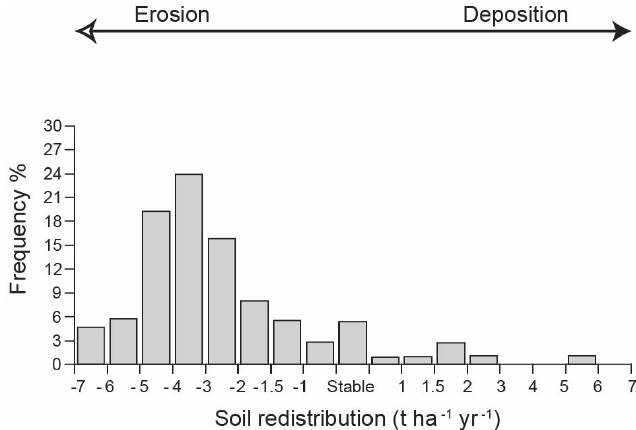
Fig. 4 The range of erosion and deposition rates (t ha -1 year -1 ), estimated using the 137 Cs measurements obtained for the sampling points within the study